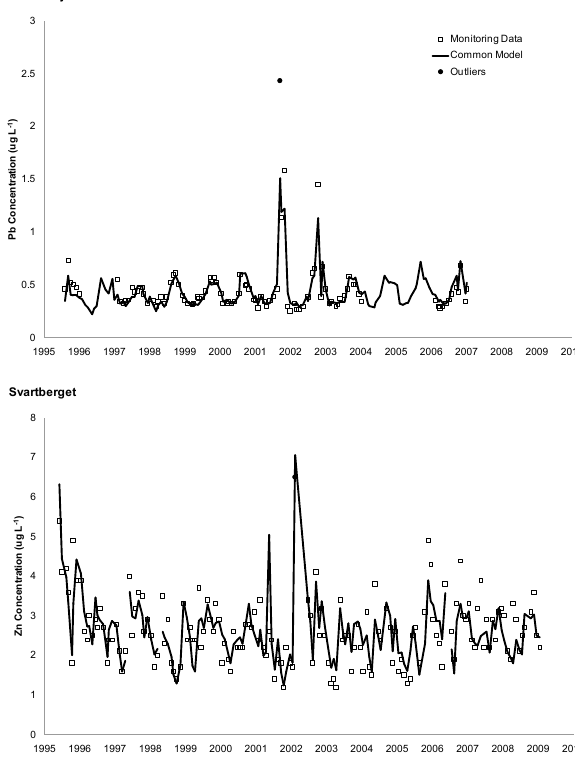
Fig. 3. Monitored and modeled data for Pb and Zn from Kind- Figure 3. Monitored and modeled data for Zn and Pb from selected sites. Data originally excluded fom analysis as outliers are shown as well. lah¨ojden IM (A) and Svartberget (B) , respectively. Data originally excluded from analysis as outliers are shown as